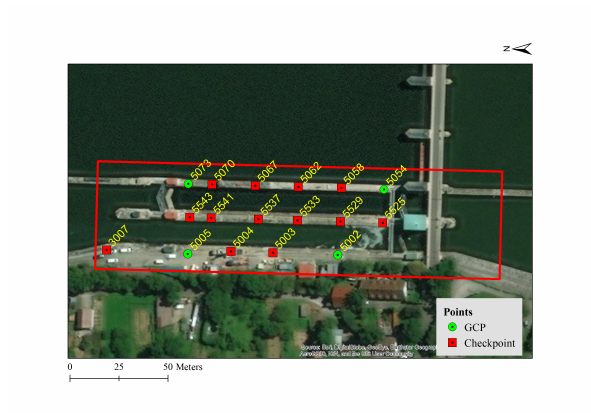
Figure 4. Test area and all reference points. The green circle stands for ground control points and red rectangles are